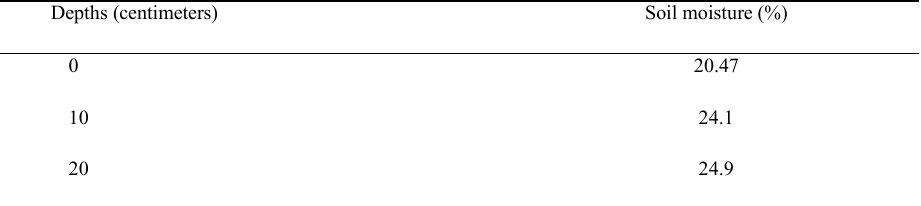
The retention amount of green